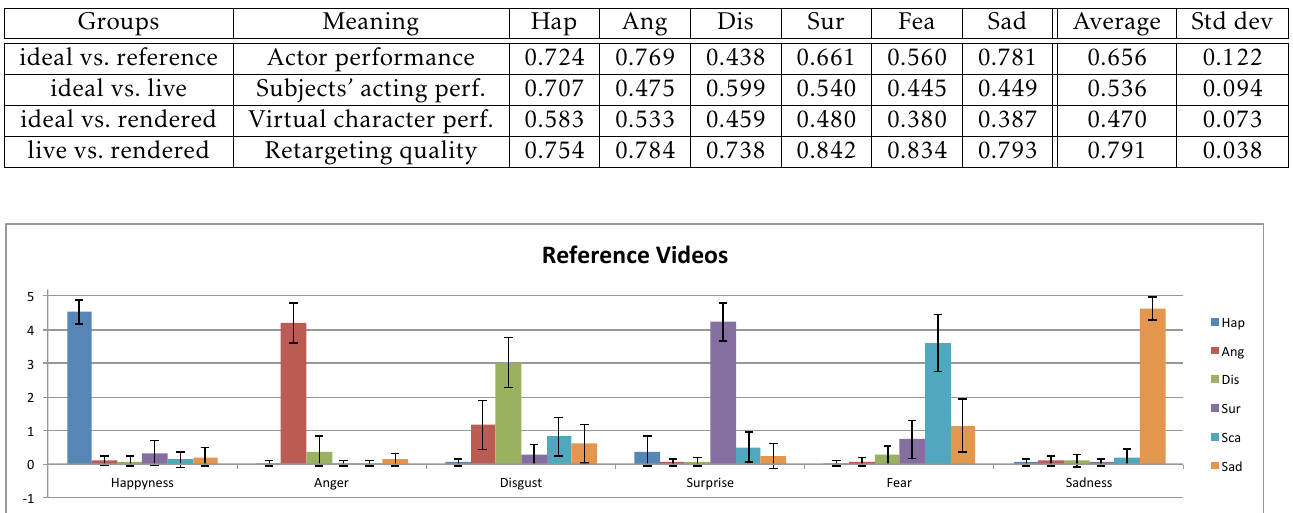
Figure 8. Rating obtained for the reference videos (actor) for each